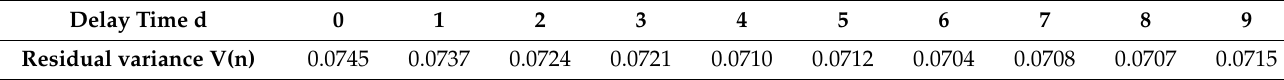
Table 3. Identification results of  and k for heading loop with different delay time parameter d. Delay Time d